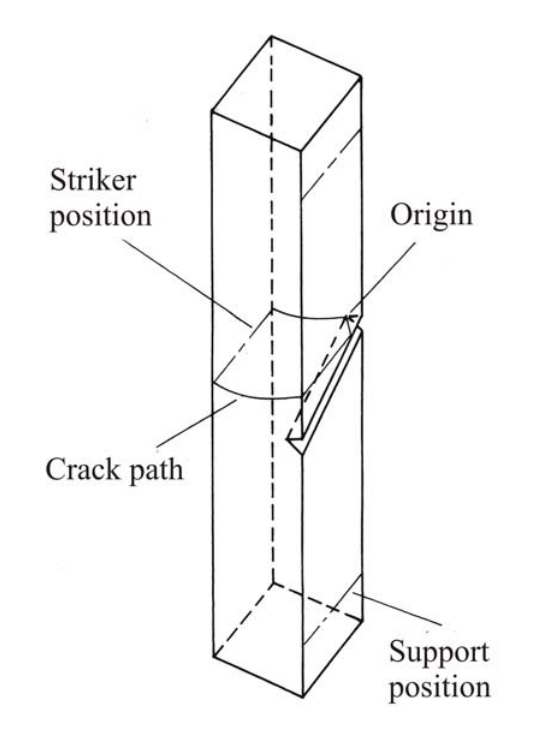
Figure 17. Crack in burner from domestic central heating